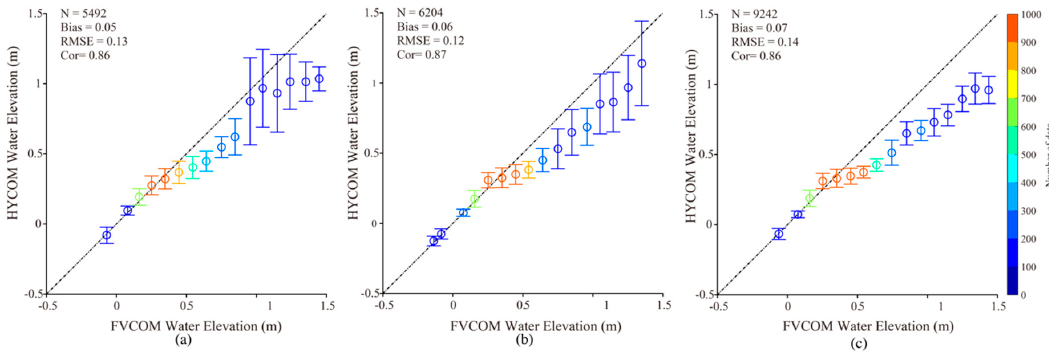
Figure 10. Comparison between sea-water level simulated by the FVCOM and the HYCOM data for a 0.1-m bin between − 0.5 and 1.5 m, in which the error bar represents the standard deviation at each bin for the matchups in (a) Region A; (b) Region B; and (c) Region C.